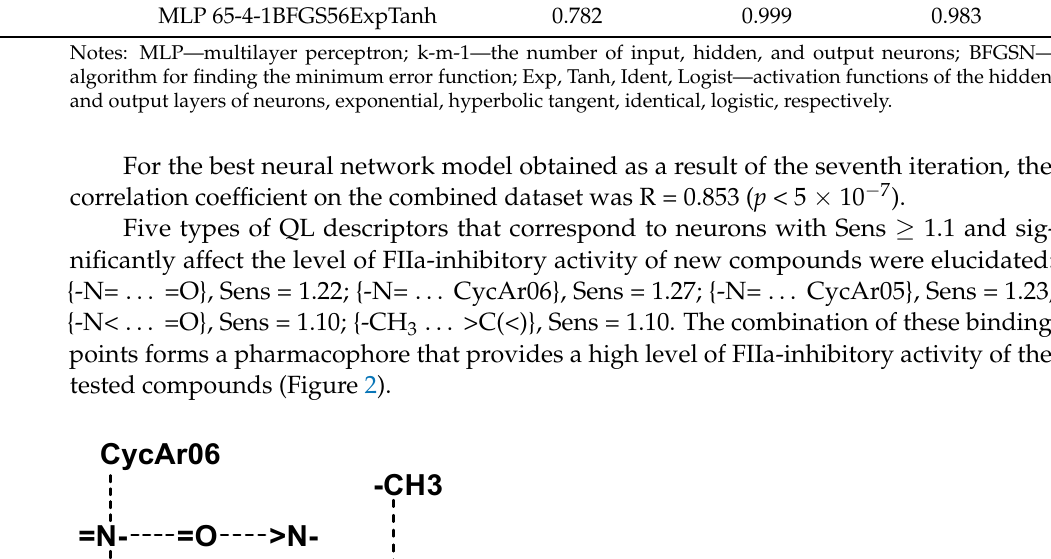
Table 3. Entry of the identified pharmacophore into structures of the most active FIIa inhibitors and dabigatran etexilate .